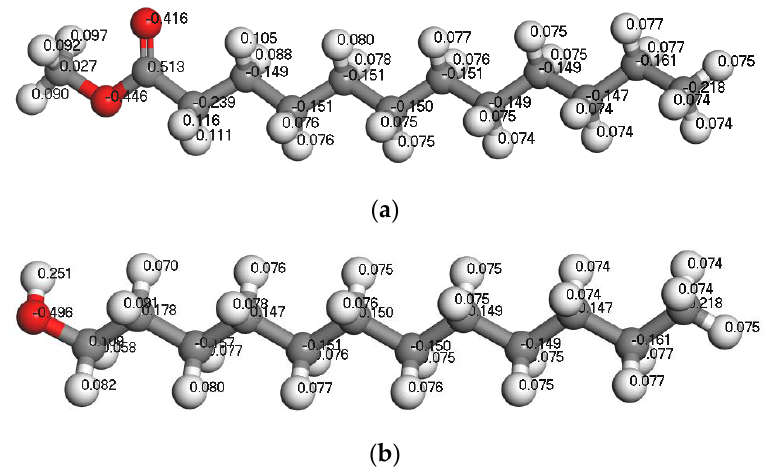
Figure 7. The structures of the selected collectors: ( a ) methyl laurate and ( b ) dodecanol. The representation of gray, white, and red is the C, H, and O atom, respectively.